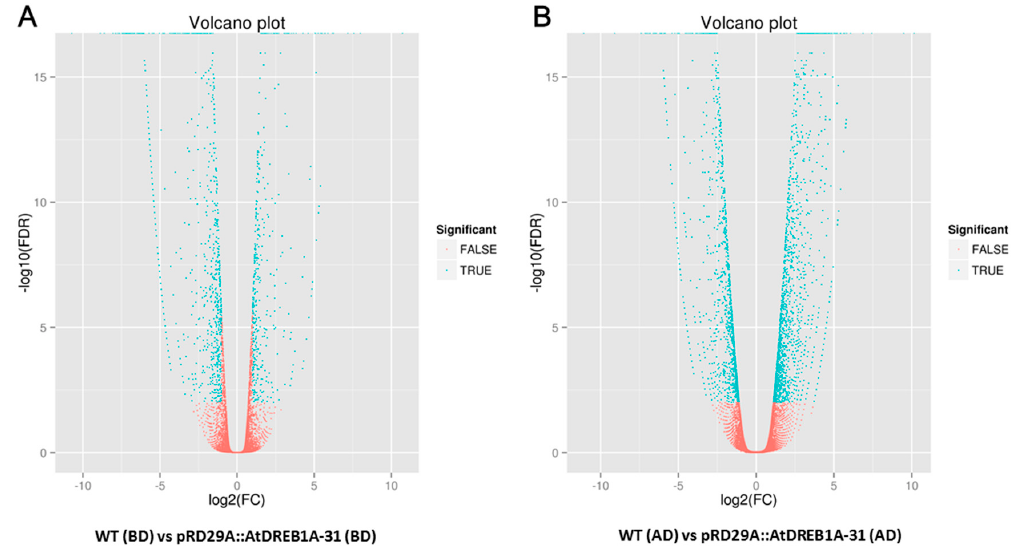
Figure 1. Volcano plots of differentially expressed genes (DEGs) in the comparisons of AtDREB1A -overexpressing and wild-type (WT) plants of Salvia miltiorrhiza before and after drought treatment. ( A ) WT (BD) versus pRD29A::AtDREB1A-31 (BD); ( B ) WT (AD) versus pRD29A::AtDREB1A-31 (AD). WT, wild type plants of Salvia miltiorrhiza ; pRD29A::AtDREB1A-31, pRD29A::AtDREB1A transgenic line 31. BD, before drought; AD, after six days of drought treatment.